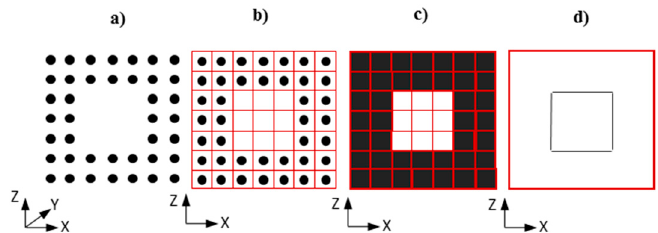
Figure 3. ( a ) Point cloud; ( b ) point cloud projected into a rectangular matrix; ( c ) binarized image; ( d ) edge image (adapted from [35]).